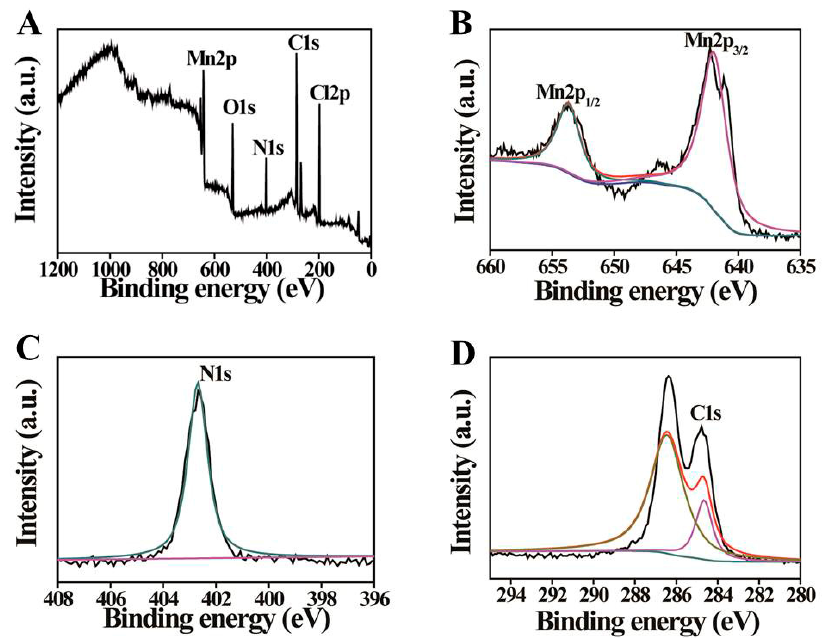
Figure 2. X-ray photoelectron spectroscopy (XPS) spectra of MnO 2 nanosheets—( A ) survey spectrum, ( B ) Mn 2p spectrum, ( C ) N 1s spectrum and ( D ) C 1s spectrum.